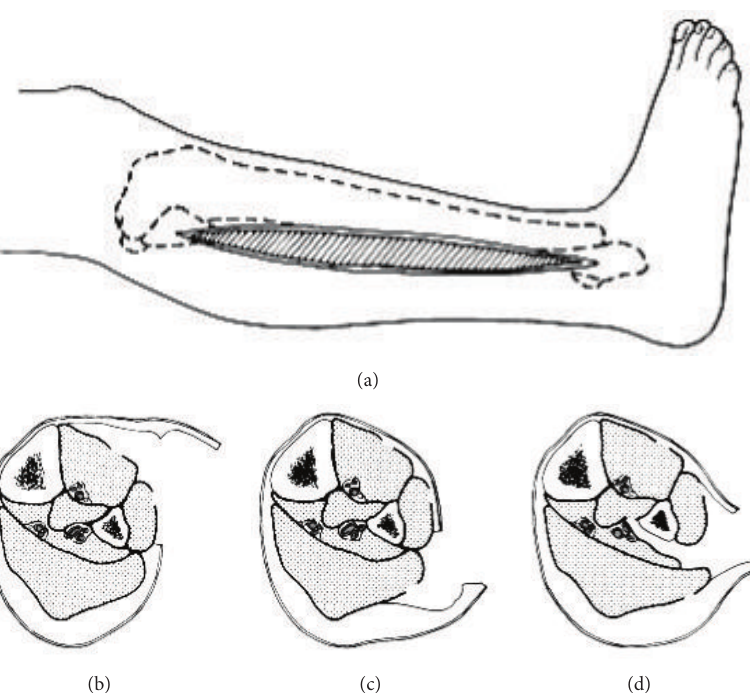
Figure 5: One-incision technique without fibulectomy. (a) Lateral skin incision from fibular neck 3 to 4cm proximal to lateral malleolus. (b) Skin is undermined anteriorly, and fasciotomy of anterior and lateral compartments is performed. (c) Skin is undermined posteriorly, and fasciotomy of superficial posterior compartment is performed. (d) Interval between superficial posterior and lateral compartments is developed. Flexor hallucis longus muscle is dissected subperiosteally off fibula and retracted posteromedially. Fascial attachment of posterior tibial muscle to fibula is incised to decompress muscle (redrawn from [34]).